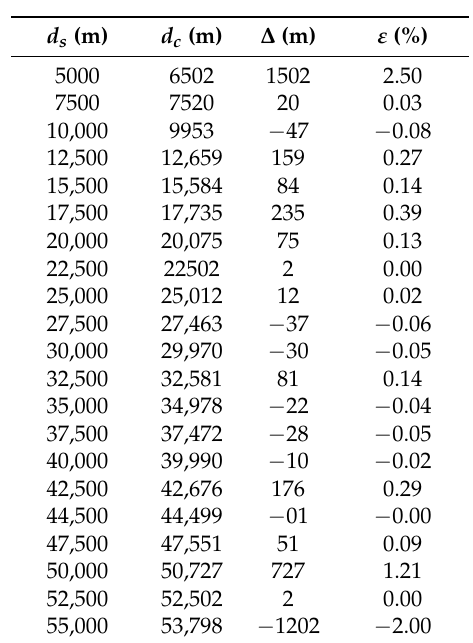
Figure 8. Variation of the percentage error with the iteration number for d s = 32.5 km (12th rows of Table 3). Table 3. Calculated Error of the Fault Location by an ANN-Based